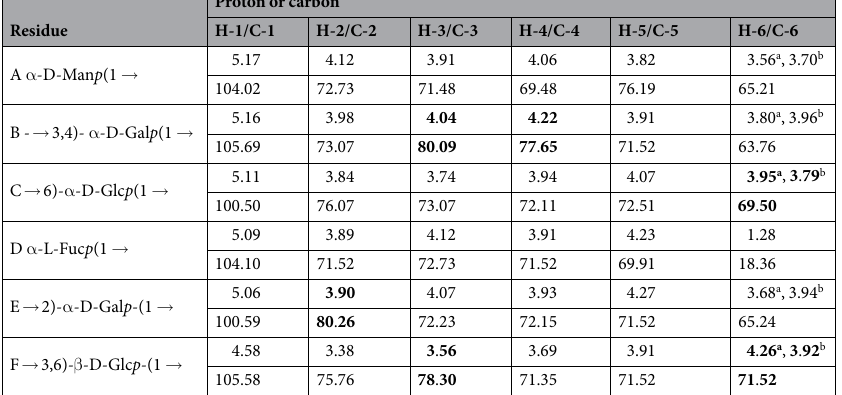
Table 1. 1 H and 13 C NMR chemical shifts (ppm) of FVPB2 at 27 °C. a Chemical shift for H-6a. b Chemical shift for